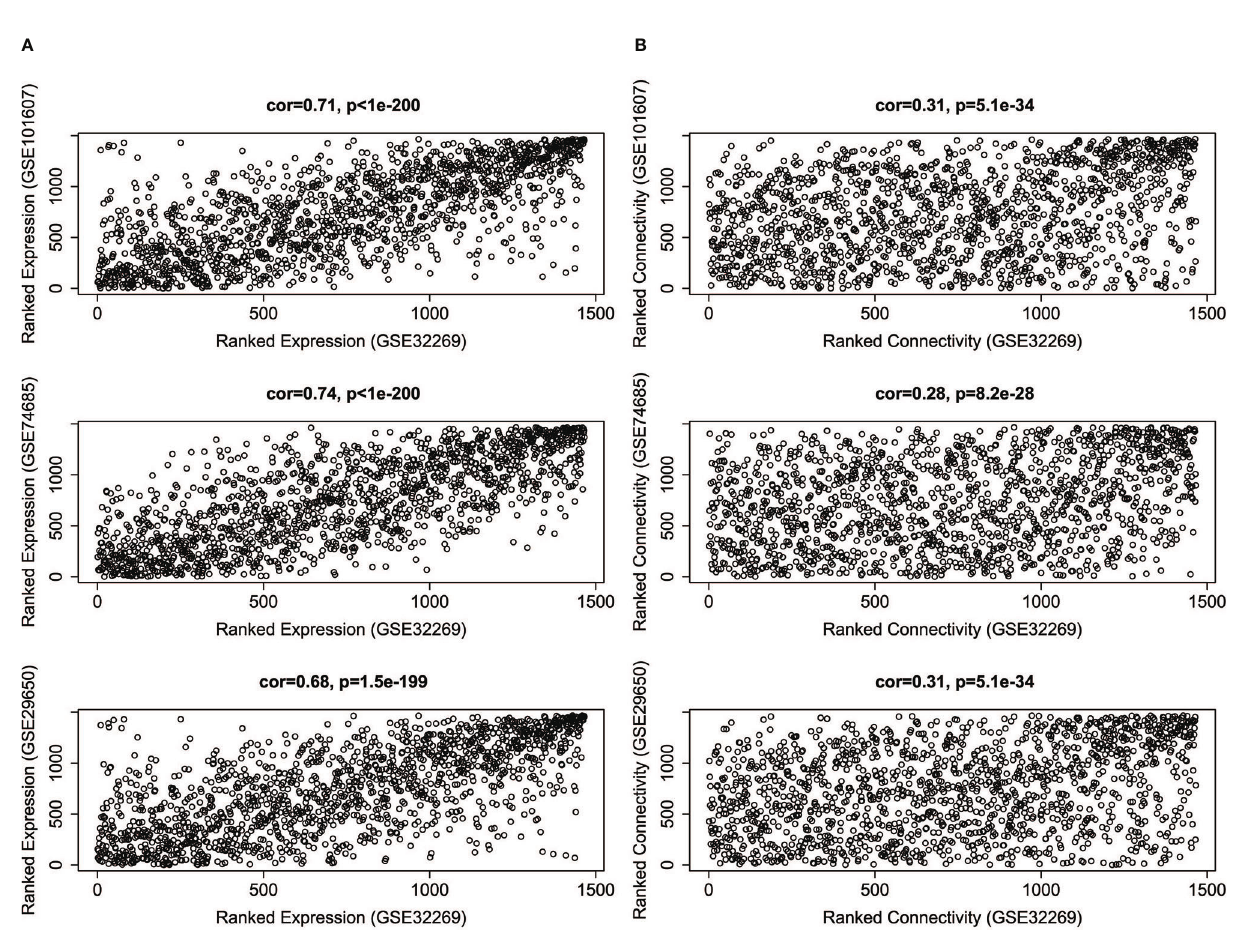
FIGURE 2 | The correlations of average gene expression (A) and overall connectivity (B) between GSE32269 and other three datasets (GSE101607, GSE74685,